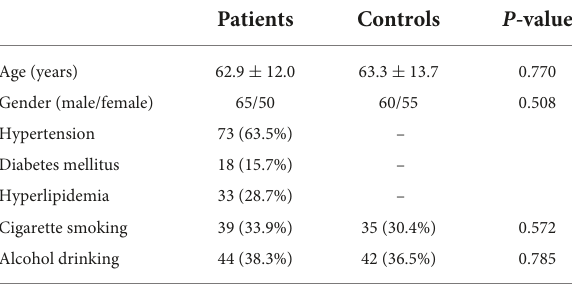
TABLE 1 Comparison of the baseline characteristics between healthy controls and patients with intracerebral hemorrhage (ICH). Patients Controls P